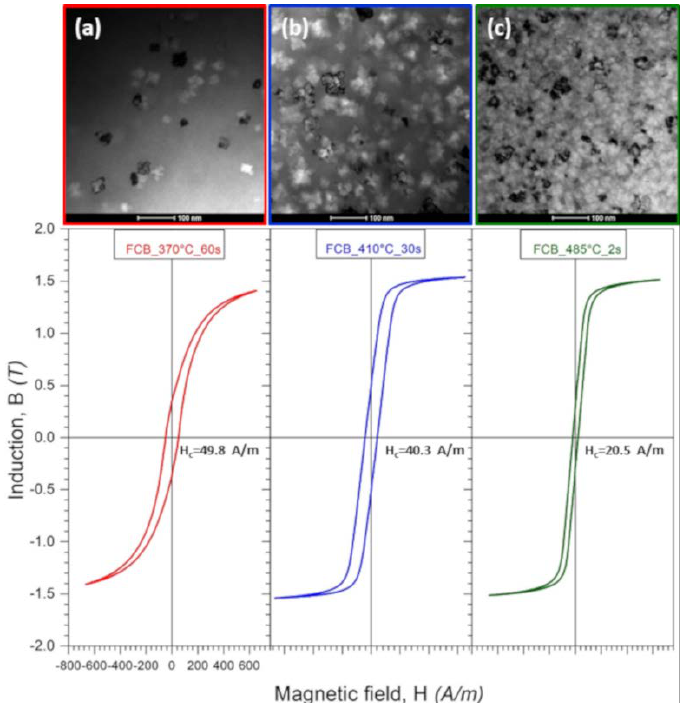
Figure 11. Microstructure (BF images) and B-H curves for Fe 67 Co 20 B 13 ribbons heat-treated at 370 °C/60 Figure11. Microstructure(BFimages)andB-HcurvesforFe 67 Co 20 B 13 ribbonsheat-treatedat370 ◦ C / 60s s ( a ), 410 °C/30 s ( b ), and 485 °C/2 s ( c ), show the change of hysteresis loops with the microstructural ( a ), 410 ◦ C / 30 s ( b ), and 485 ◦ C / 2 s ( c ), show the change of hysteresis loops with the microstructural evolution of evolution of ribbons.